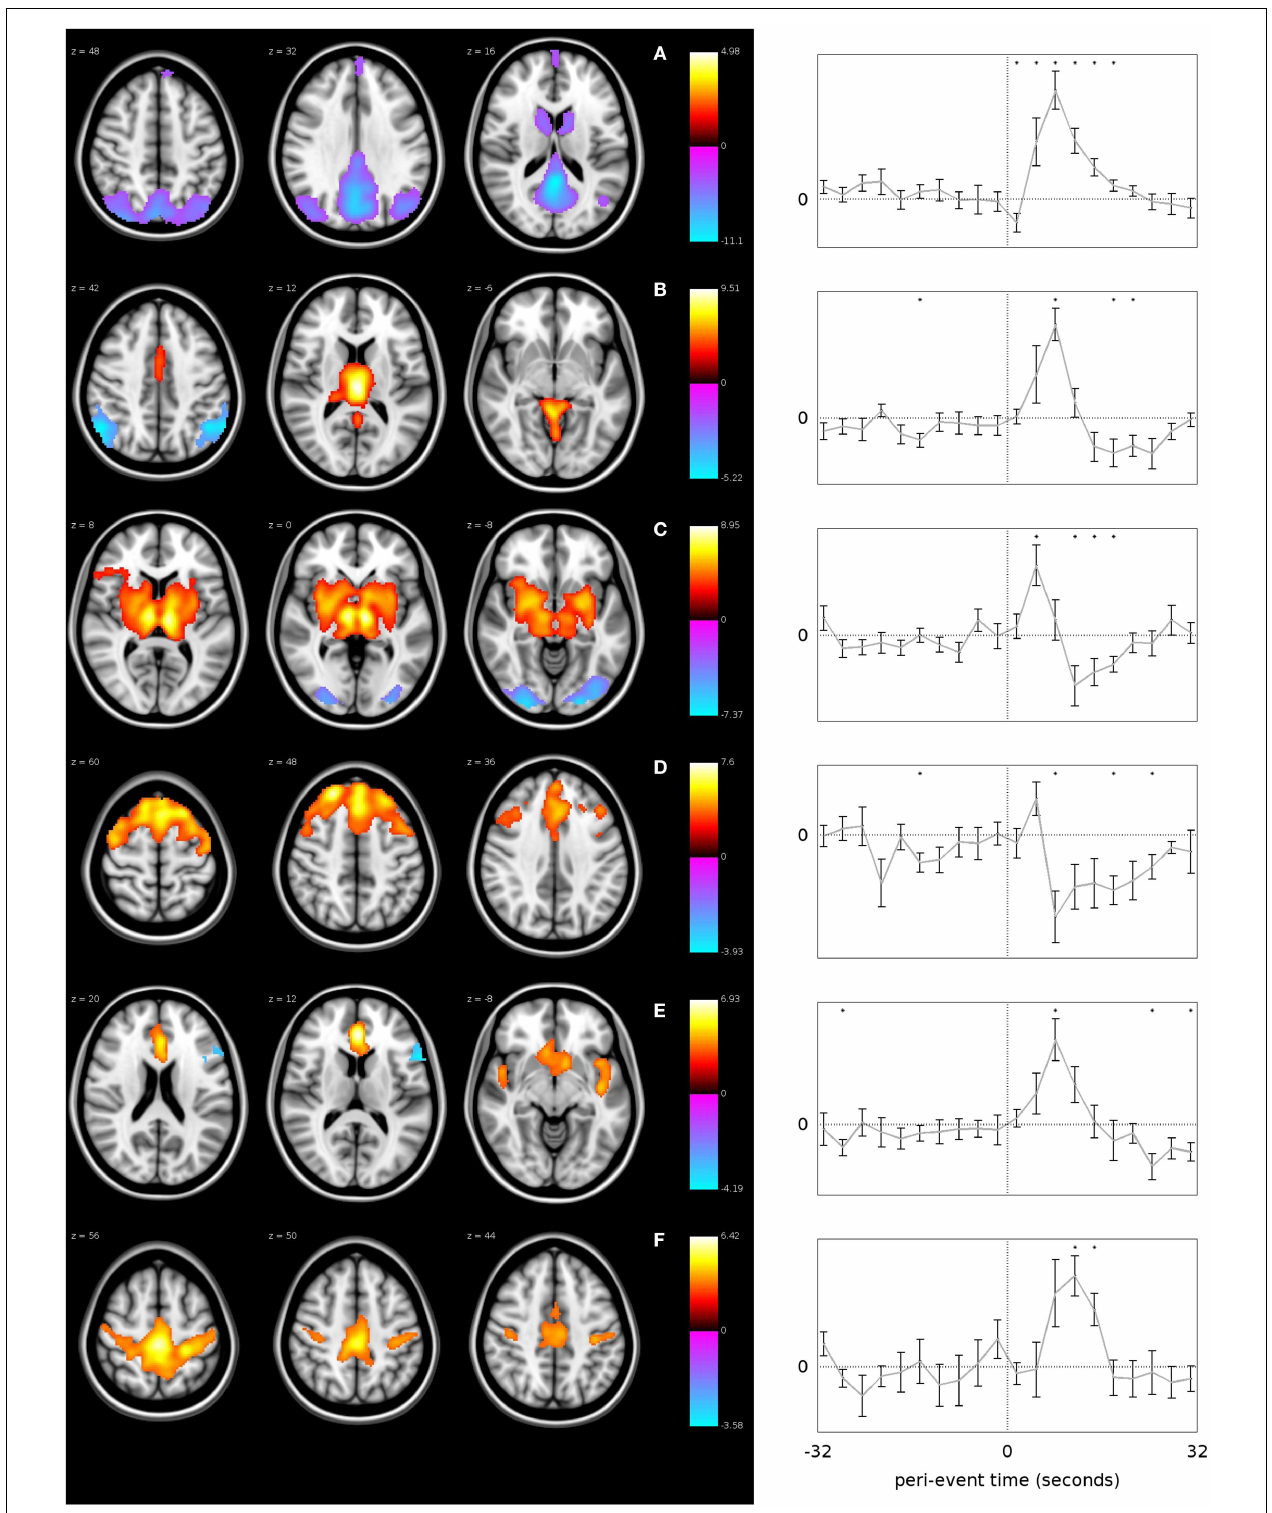
with error bars indicating the standard error, over the time period from − 32 to + 32s relative to the GSW onset.The vertical dotted line in each plot